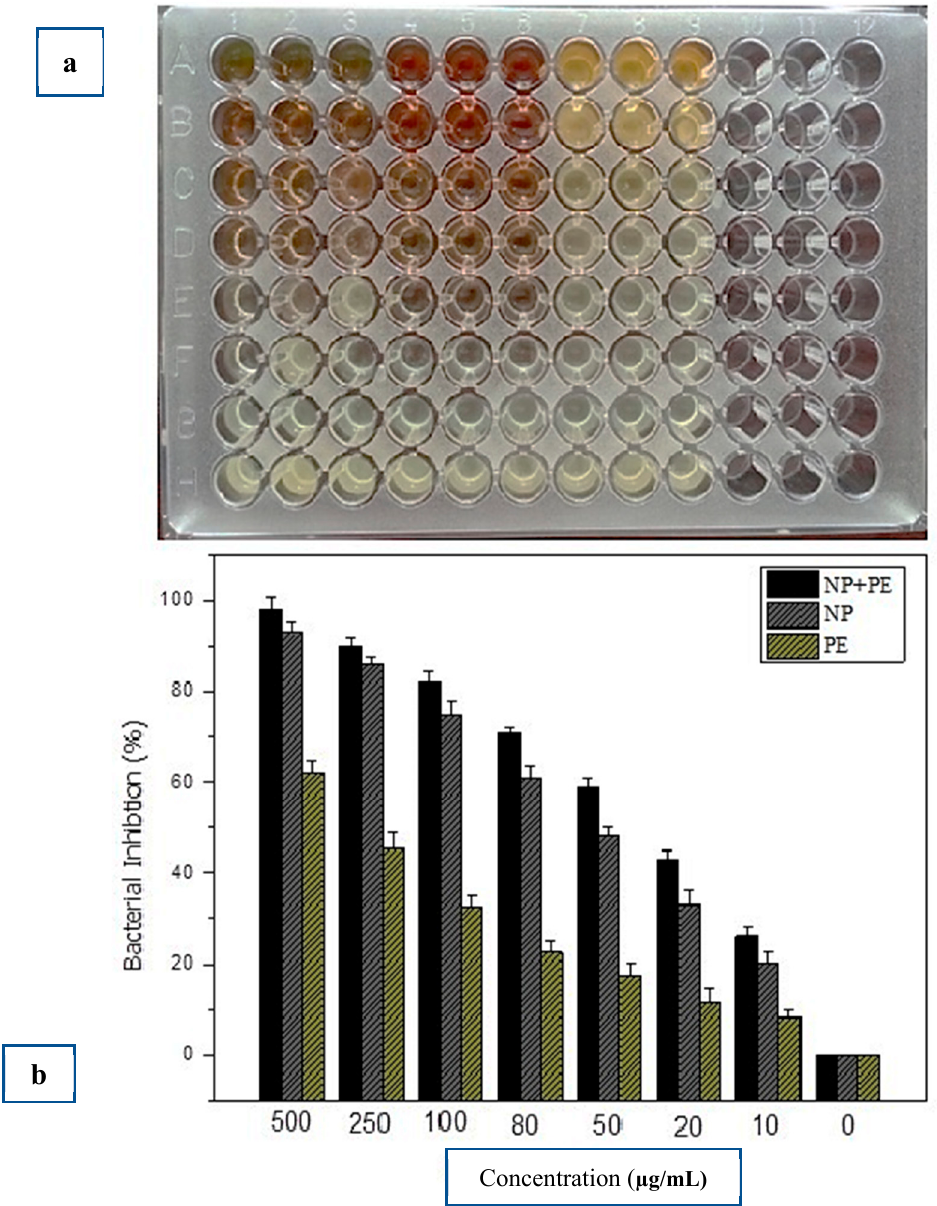
Figure 6. ( a ). Microtiterplate loaded with centrifuged NPs, plant extract and NPs in combination with plant extract along with bacteria. ( b ). Antibacterial activity graph showing inhibition of E. corotovora by various concentrations of silver/silver chloride nanoparticles alone (se-Ag/AgClNPs), in combination with leaf extract (se-Ag/AgClNPs + LE), and leaf extract alone (LE).